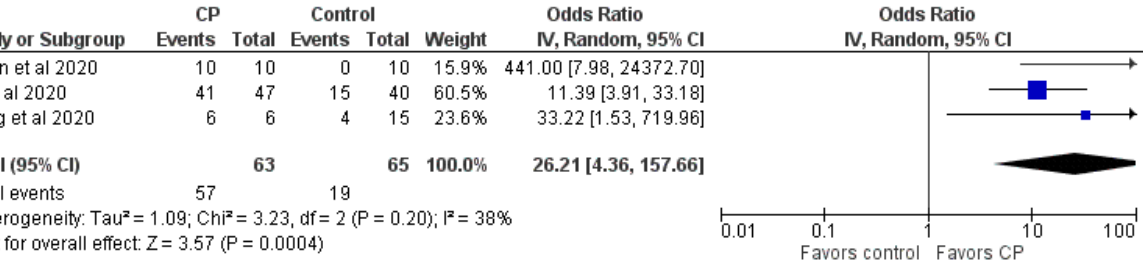
Figure 5. Efficacy of CP treatment on viral clearance in COVID-19 patients. Data from 3 controlled clinical trials were pooled using an inverse variance method and analyzed using a random-effects model. Odds ratios and 95% CIs were used as statistical measures for viral clearance as a dichotomous outcome. CP: convalescent